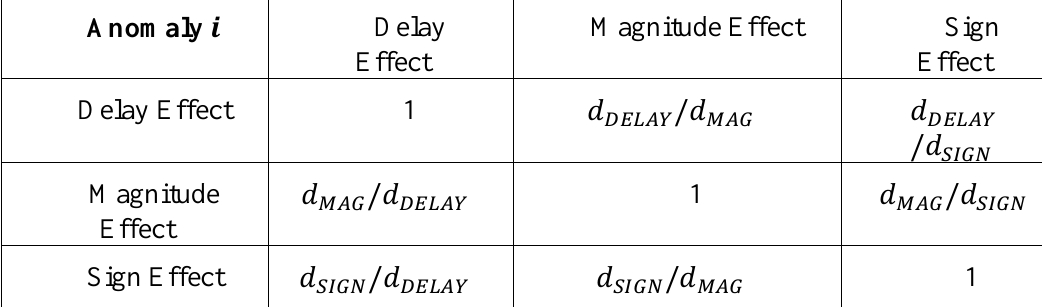
Table 8: Pairwise comparison matrices between temperaments i and subjective perception of